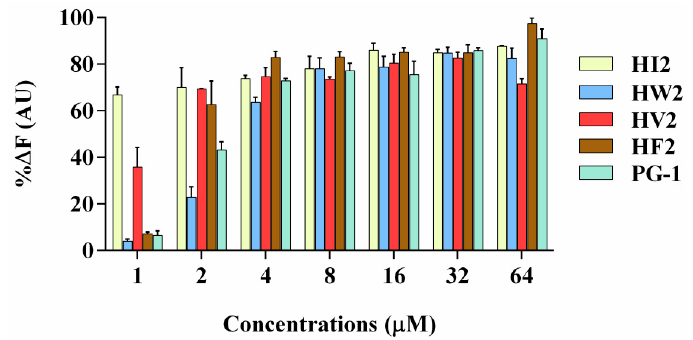
Figure 5. The combining ability of HI2, HW2, HV2, HF2, and PG-1 (1 µ M, 2 µ M, 4 µ M, 8 µ M, 16 µ M, 32 µ M, and 64 µ M) with LPS. 50 µ g / mL LPS from E. coli O111:B4 was incubated with 5 µ g / mL BODIPY-TR cadaverine in Tris bu ff er (50 mM, pH 7.4) for 4 h at room temperature. Subsequently, the peptides were serially diluted in Tris bu ff er and incubated with equal volumes of the LPS-probe mixture for 1 h in a 96-well black plate. The fluorescence was measured (excitation λ = 580 nm, emission λ = 620 nm) on a spectrofluorophotometer.